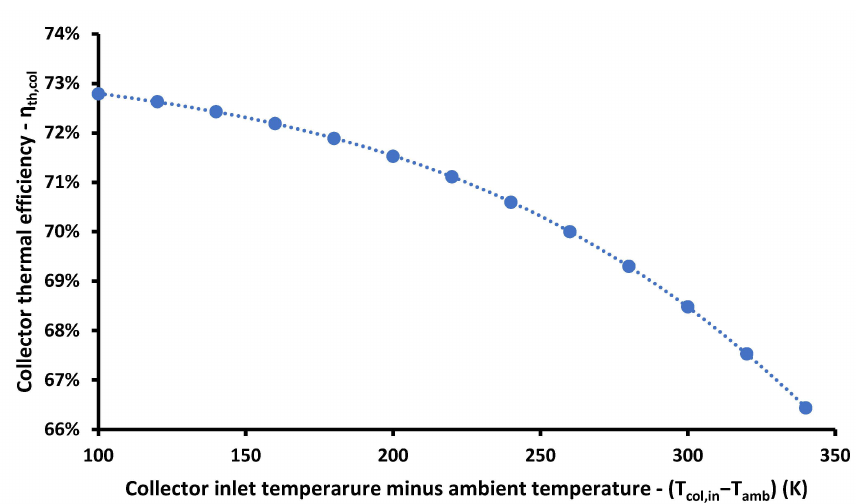
Figure 4. Collector thermal efficiency depending on the temperature difference between the collector inlet and the ambient temperature for solar beam irradiation G bn = 800 W/m 2 , and incident angle θ = 0 o .